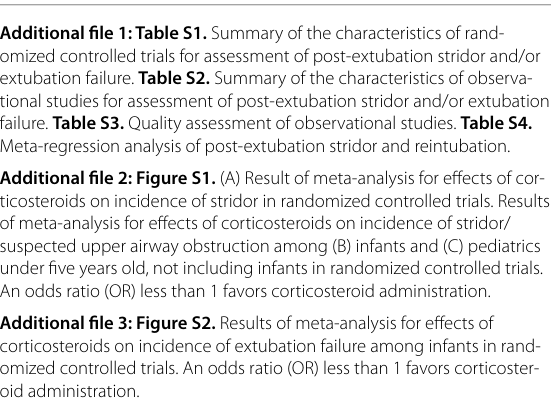
Additional file 1: Table S1. Summary of the characteristics of rand- omized controlled trials for assessment of post-extubation stridor and/or extubation failure. Table S2. Summary of the characteristics of observa- tional studies for assessment of post-extubation stridor and/or extubation failure. Table S3. Quality assessment of observational studies. Table S4. Meta-regression analysis of post-extubation stridor and